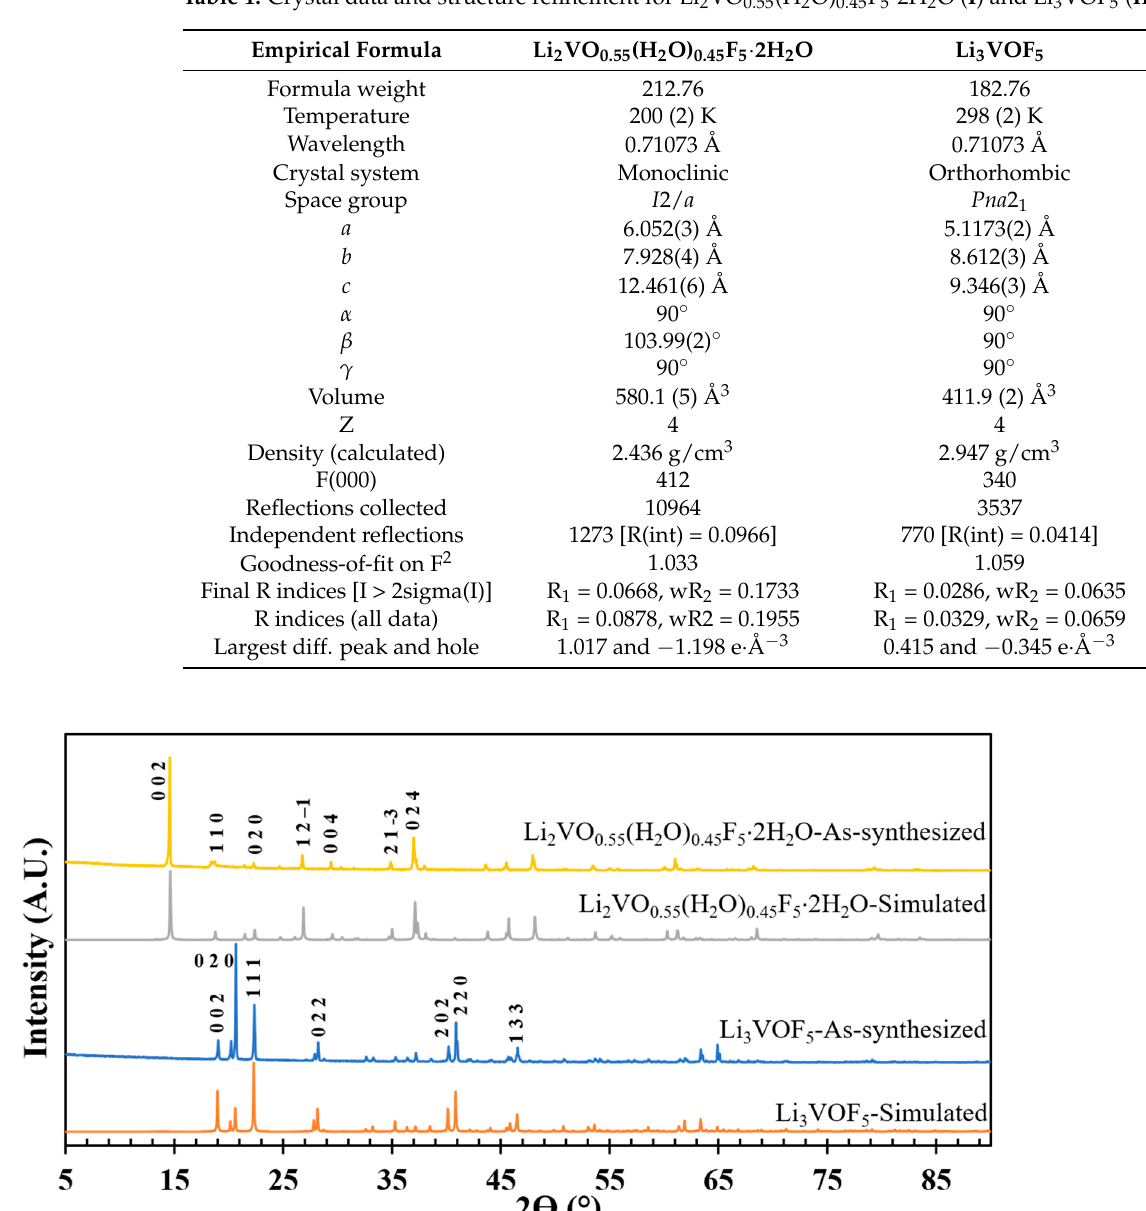
Table 1. Crystal data and structure refinement for Li 2 VO 0.55 (H 2 O) 0.45 F 5 ⋅ 2H 2 O ( I ) and Li 3 VOF 5 ( II ).